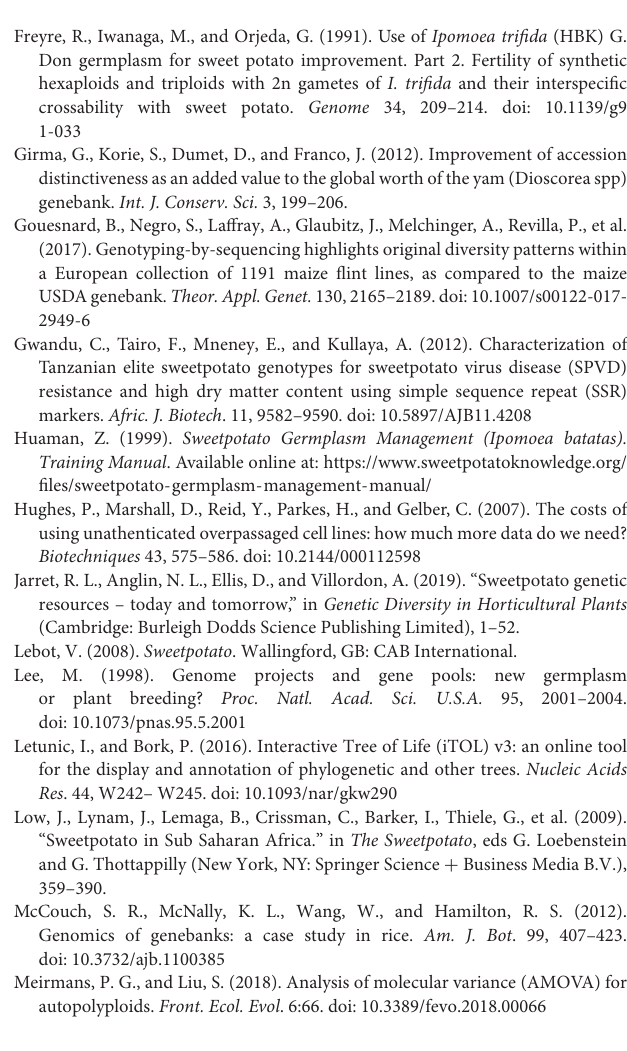
Supplementary Figure 1 | Principal Component Analysis (PCoA) of entire sweetpotato collections (5,979 accessions). Country of origin or donation country color code: Peru = purple. Red = Venezuela and Colombia. Green = Mexico and